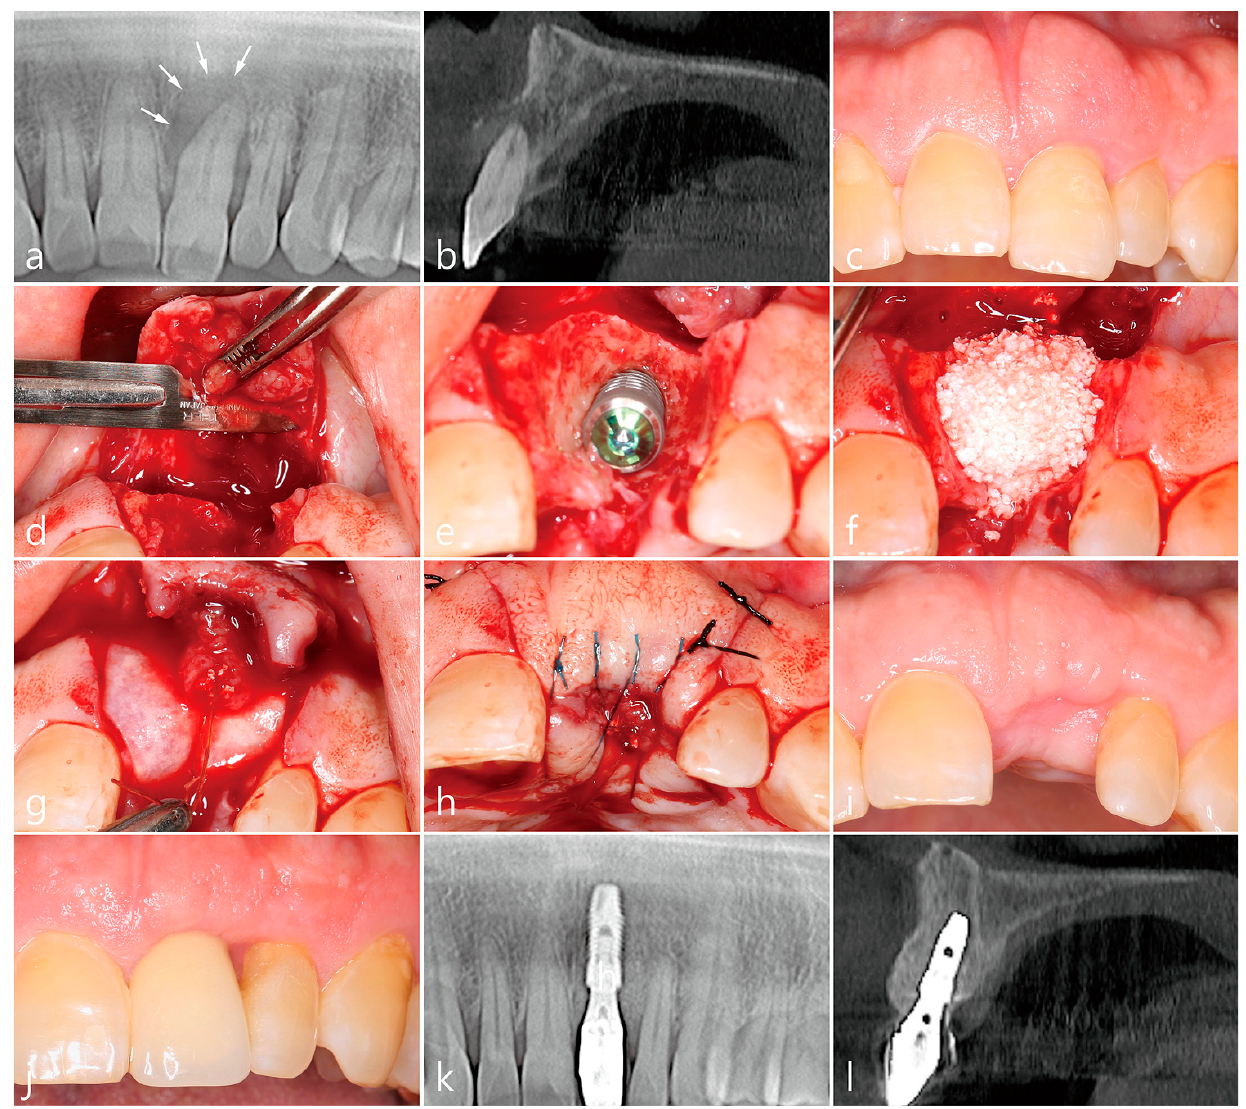
Figure 1. Clinical and radiological findings of case #1. ( a ) Pre-operative panoramic radiograph showing severe bone resorption and periapical radiolucency around the root of #21 (white arrow). ( b ) Cross-sectional image of CBCT #21 showing ICT around #21. ( c ) Pre-operative photograph #21. ( d ) Flap extension by dissection of the ICT attached to the buccal flap with the base attached to the existing flap using a #15 blade. ( e ) Implant #21 placement with peri-implant osseous defect. ( f ) Bone graft placement over implant. ( g ) Resorbable collagen membrane placement and extended IGT sutured to the palatal flap with resorbable sutures. ( h ) Primary closure with extended IGT. ( i ) Post- operative photograph showing no flap exposure. ( j ) Final prosthesis #21. ( k ) Panoramic radiograph taken 12 months after prosthesis delivery. ( l ) Cross-sectional image of CBCT taken 12 months after prosthesis delivery with sufficient bone regenerated around the implant.